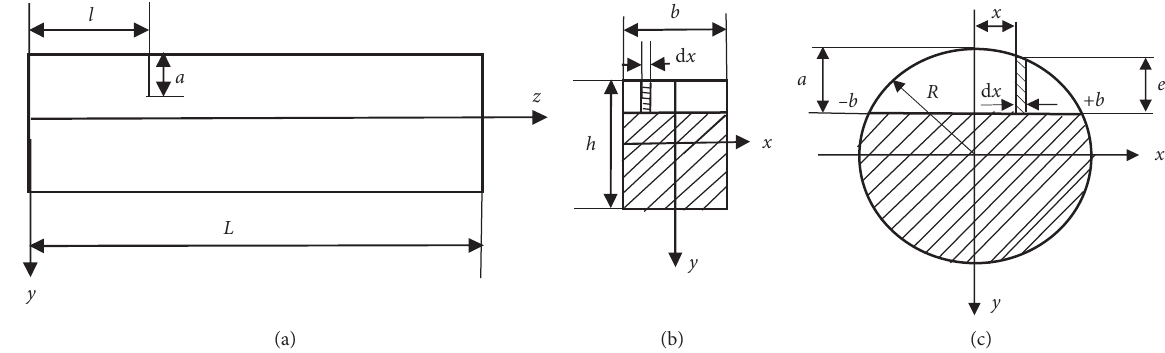
Figure 1: The model of the cracked beam. (a) Schematic diagram of cracked beam. (b) Rectangular beam crack cross section. (c) Circular beam crack cross section.